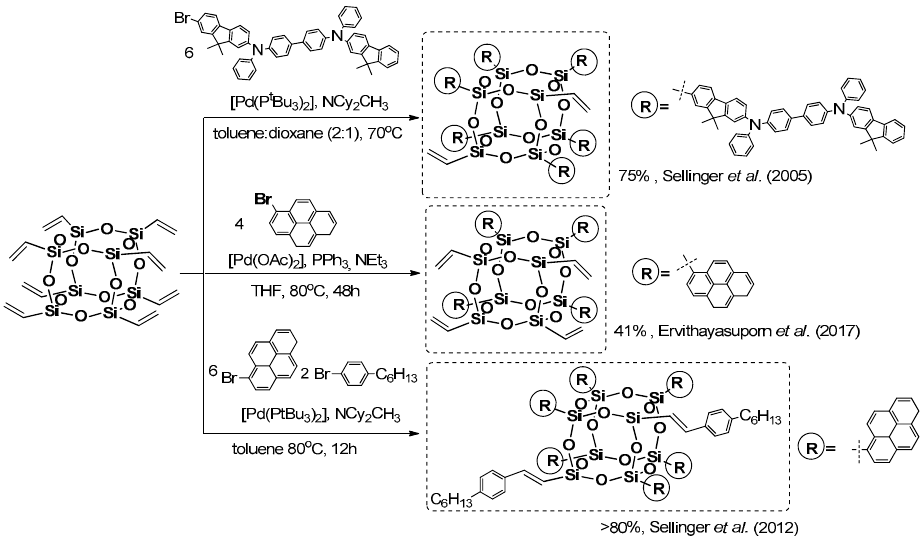
Figure 7. Heck coupling reaction leading to formation of T 8 -based systems with two functionalities.